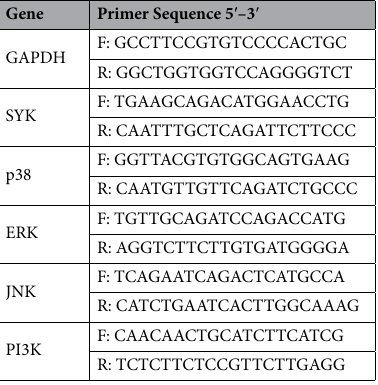
Table 2. Sequences of real-time PCR